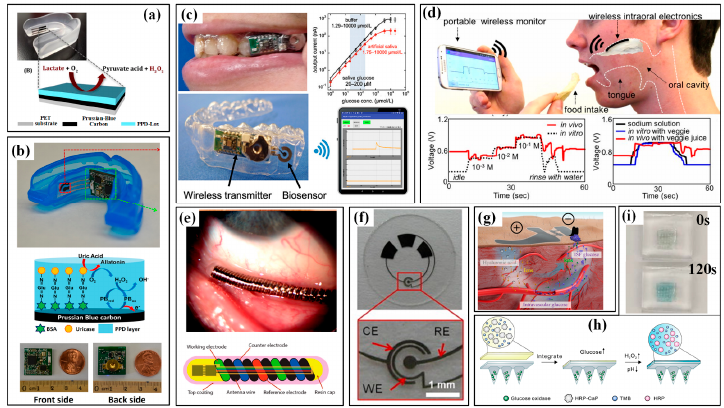
Figure 17. The wearable sensors for saliva, tear and ISF analysis: ( a ) the mouthguard for salivary lactate monitoring [171]; ( b ) the photo (up), mechanism (middle) and circuit photo (down) of the mouthguard for salivary uric acid monitoring [172]; ( c ) the mouthguard for salivary glucose mon- itoring [173]; (d) the intraoral sensors for real-time quantification of sodium intake [174]; ( e ) the sensor for monitoring the tear glucose [175]; ( f ) soft contact lens for monitoring the tear glucose [177]; ( g ) illustration for monitoring the ISF glucose based on reverse iontophoresis [179]; ( h ) the micronee- dles array for monitoring the ISF glucose and ( i ) its colorimetric results [180]. Reproduced with permissions from The Royal Society of Chemistry (2014) [171]. Reproduced with permissions from Elsevier (2015) [172]. Reproduced with permissions from American Chemical Society (2020) [173]. Reproduced with permissions from The National Academy of Sciences (2018) [174]. Reproduced with permissions from Elsevier (2020)